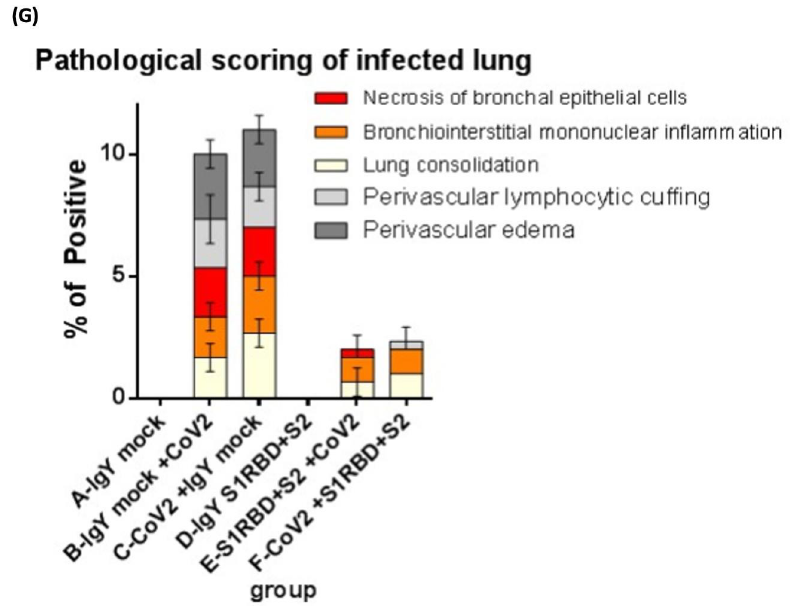
Figure 5. Effect of IgYs specific for S1-RBD and S2 subunits on pathological changes in SARS-CoV- 2-infected lung tissues in vivo. The efficacy of treatment with the combination of IgYs specific for S1-RBD and S2 subunits (IgY S1RBD + S2) was examined in Syrian hamsters, and IgY from mock infection was used as the control (IgY Mock). IgYs were simultaneously delivered intranasally and intraperitoneally, either 1.5 h before or after the intranasal delivery of the SARS-CoV-2 Wuhan strain. Four days after SARS-CoV-2 infection, infected hamsters were sacrificed and the lung tissues from hamsters with indicated treatment were collected. Pathological changes in lung sections from Syrian hamsters with indicated IgY pre-treatments are shown (Panels ( A – F )). Results of H&E staining are presented using representative images of three independent experiments. Images of H&E staining with lower (the upper subpanel in each panel, scale bar = 500 µ m) and higher magnification (the middle and lower subpanels in each panel, scale bar = 50 µ m) are shown. In panels ( A , D ), homogeneous interstitial and alveolar spaces are noted. In panels ( B , C ), various high cellularity patches show inflammatory cell infiltration around bronchioles proximal to the bronchus. In panel ( B ), remarkable lymphocytic–neutrophilic infiltration is observed; in panel ( C ), the necrotic changes of the bronchial lumen epithelium, lymphocytic adhesion to endothelium, and perivascular edema are noted. In panel ( G ), the pathological score based on various parameters, including necrosis of bronchial epithelial cells, bronchiointerstitial mononuclear inflammation, lung consolidation, perivascular lymphocytic cuffing, and perivascular edema, is calculated.